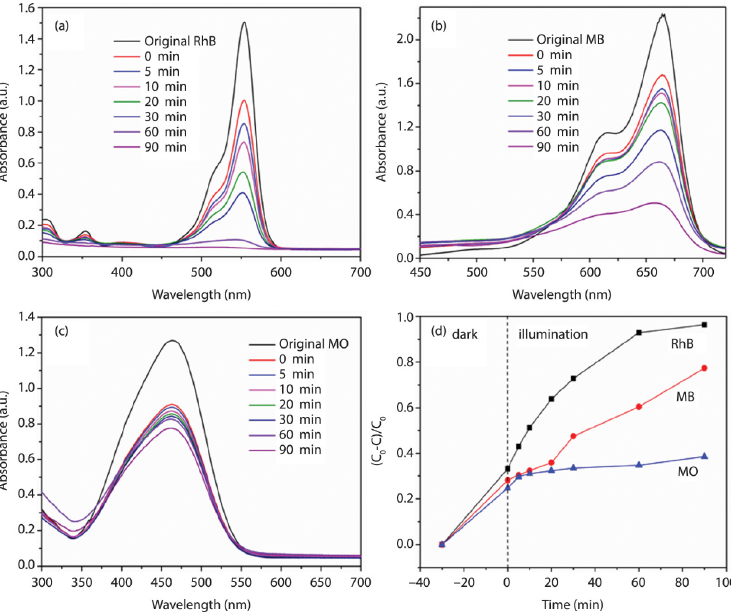
Figure 8. Effect of pH on the zeta potential of Ag in aqueous solution (T= 25 °C).